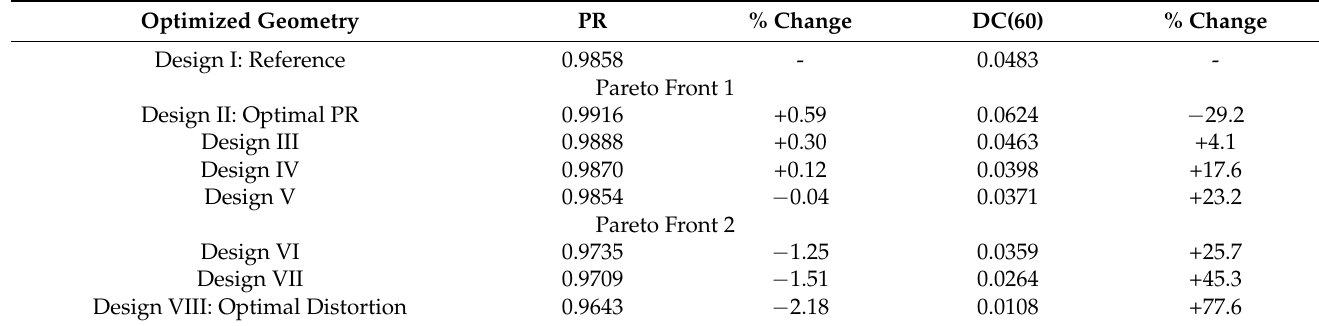
Table 5. Comparison of the Pareto optimal designs of the centerline deformation